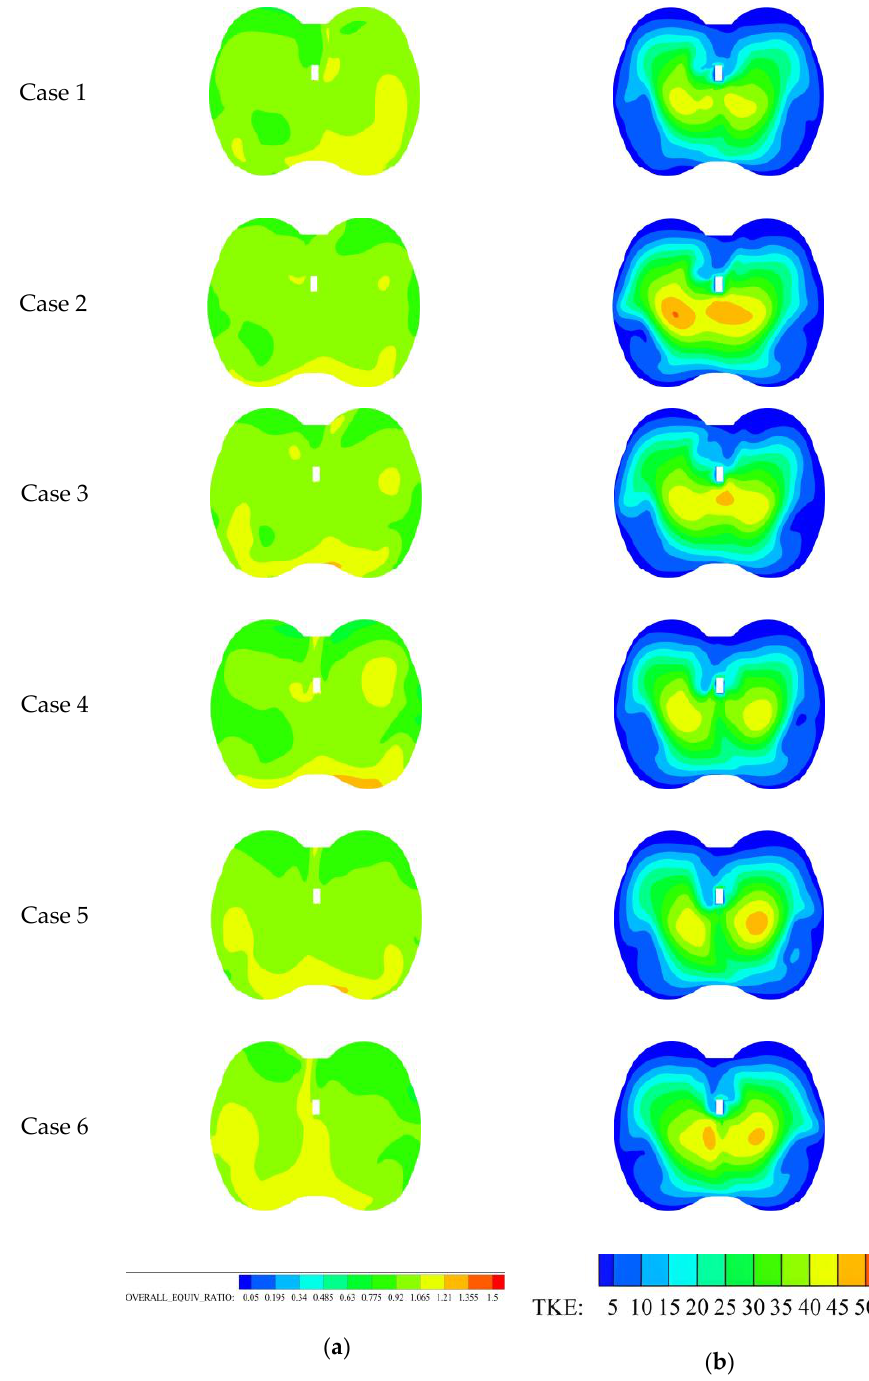
Figure 9. The distribution of water at the moment of ignition time in different water injection cases (CR = 10.3, ignition time = − 14 degCA).